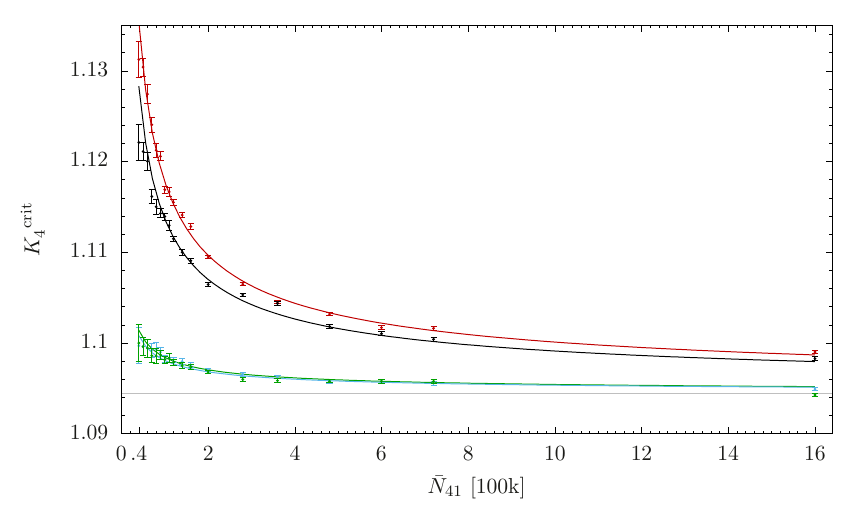
Figure 5 . The pseudo-critical value K crit (cid:12)ts of formula (2.3) with (cid:12)xed common values of (cid:13) = 1 : 62 and K crit follow the convention used in (cid:12)gure